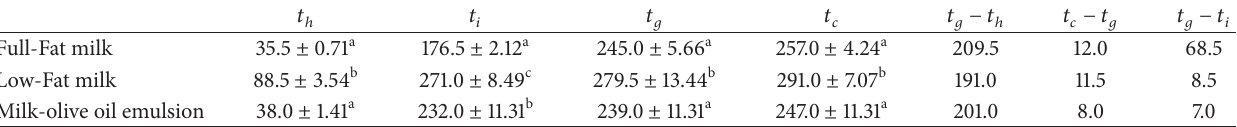
Table 2: Experimental values of characteristic points of the enzymatic coagulation of the milk samples (min). 𝑡 ℎ